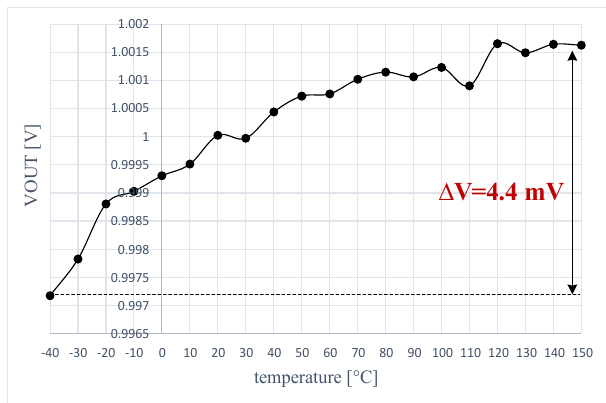
Figure 22. Measured temperature drift of the LDO output voltage error for VIN = 1.5 V, IL = 1 mA, and CL = 100 pF. and CL = 100